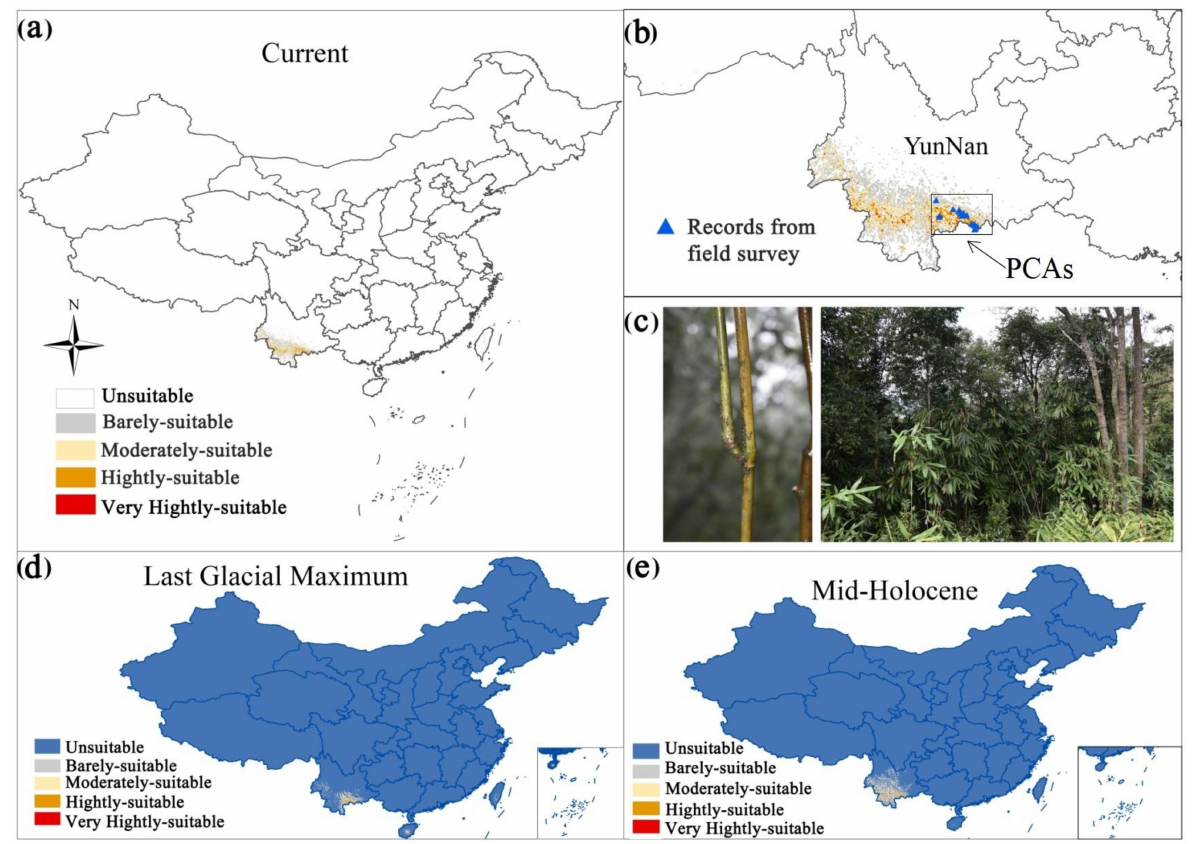
Figure 1. Current distribution of the potential suitable areas for Ferrocalamus strictus ( a ). The current distribution and priority conservation areas of Ferrocalamus strictus ( b ). A picture of a whole F. strictus specimen ( c ). Potential distribution area of Ferrocalamus strictus in the mid-Holocene (approximately 6 kya) ( d ) and Last Glacial Maximum (approximately 21 kya) ( e ) periods.